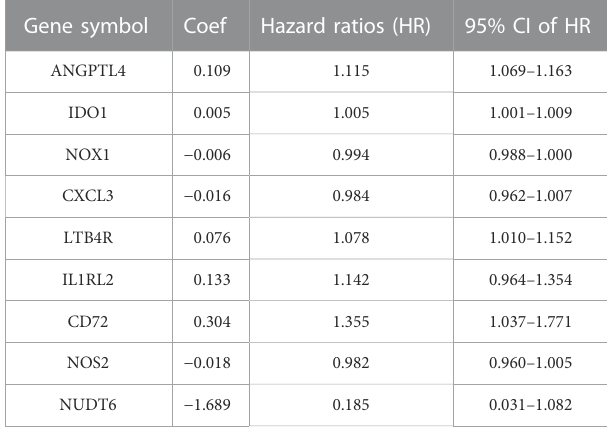
TABLE 2 Multivariate Cox analysis results of training dataset. Gene